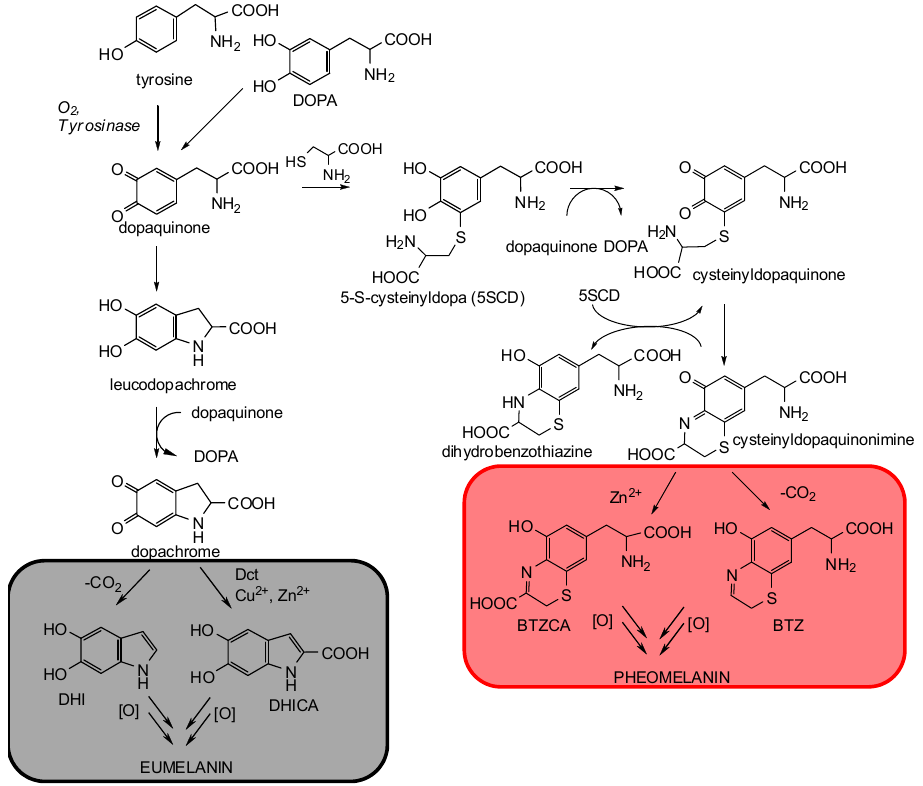
Scheme 1. Schematic view of eumelanin and pheomelanin biosynthetic